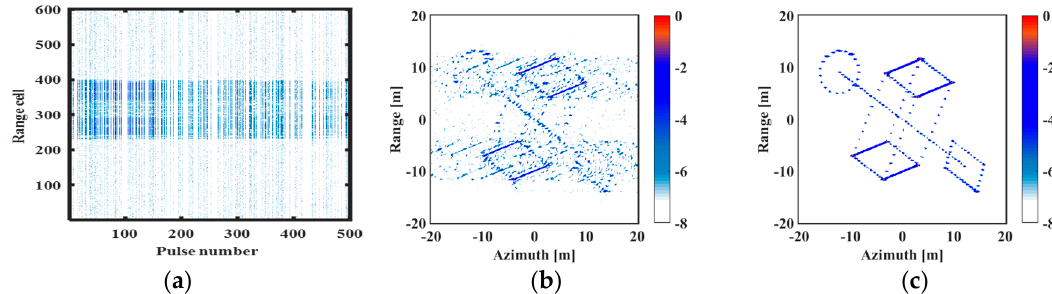
Figure 6. Range profiles and imaging results with RMS of 300 pulses: ( a ) Range profiles; ( b ) Imaging result of algorithm in [23]; ( c ) Imaging result of the proposed algorithm.